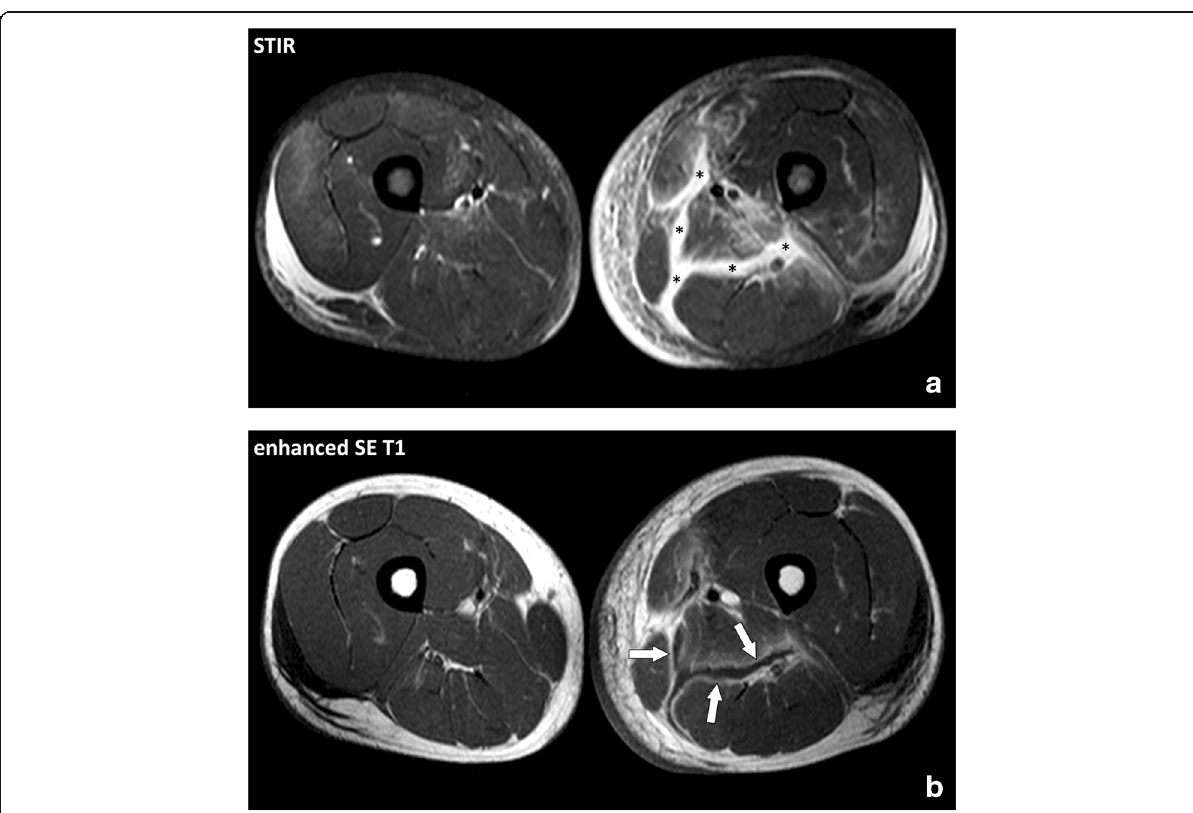
Fig. 10 Axial ( a ) STIR and ( b ) contrast-enhanced SE T1w images of the thighs of a 34-year-old male with Staphylococcus aureus septicemia and necrotizing fasciitis of the left thigh. MRI demonstrates thickening of the deep intermuscular fasciae of the posteromedial compartment of the thigh with fluid-like signal on the STIR image (asterisks) and enhancement adjacent to the necrotic fasciae after contrast material injection (arrows)